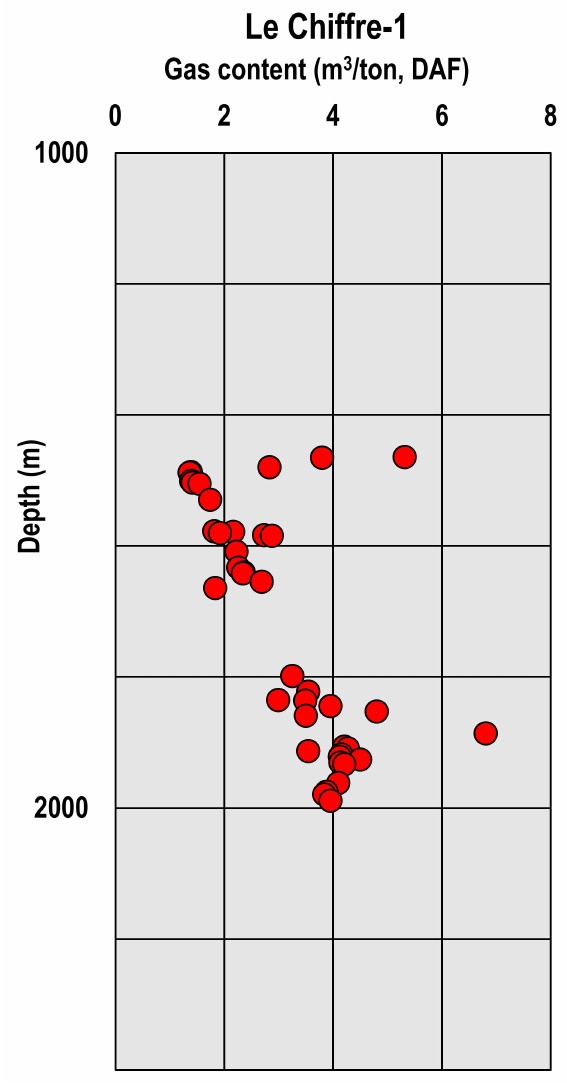
Figure 18. Gas content of deep coal seams in Le Chiffre-1 drilled in the Weena Trough, southern part of the Cooper Basin